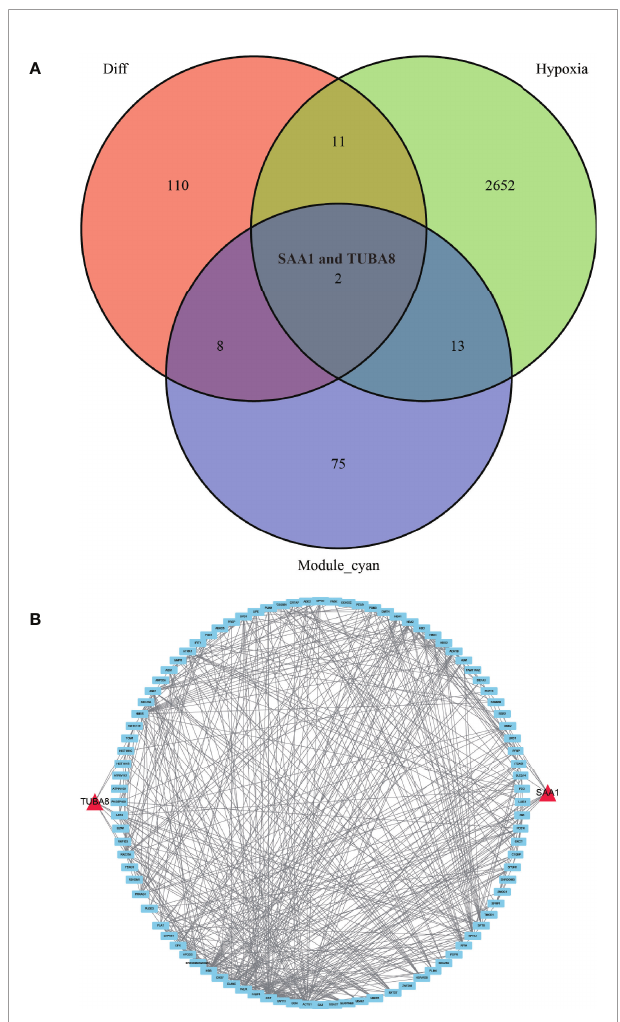
FIGURE 5 | Wayne diagram and protein-protein interaction network diagram. (A) shows the results of taking the intersection of the differentially expressed protein, the hypoxia-associated gene, and the gene from the module most associated with obligatory spondylitis. (B) shows a protein-protein interaction network in which TUBA8 and SAA1 are closely associated with multiple signi fi cantly different